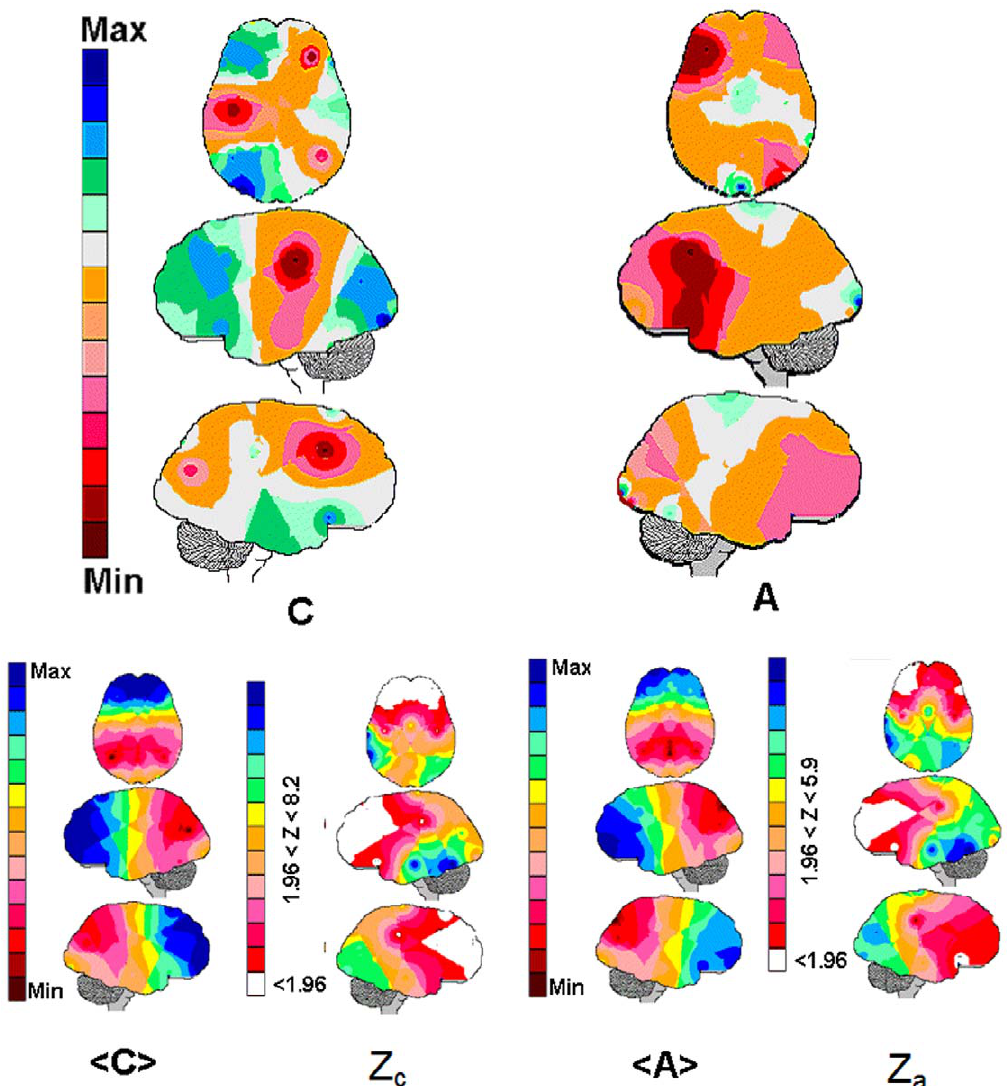
Figure 3. The EEG mappings for the calculated linear regression. IQ ~ a z b 1 h e 1 ð Þ z ::: z b 20 h e 20 ð Þ calculated for adults and children Legends as in Figure 1. The Pearson’s correlation coefficient calculated for these mappings was 2 0.16. The Z mappings Z c and Z a mappings show the differences between the averaging mappings , C . and , A . and the Hypothetical brain H in figure 4. The areas for which the Z-score is smaller than 1.96 are shown in white, and the areas for the Z-score is greater than 1.96 are collored according to the magnitude of the Z-score.